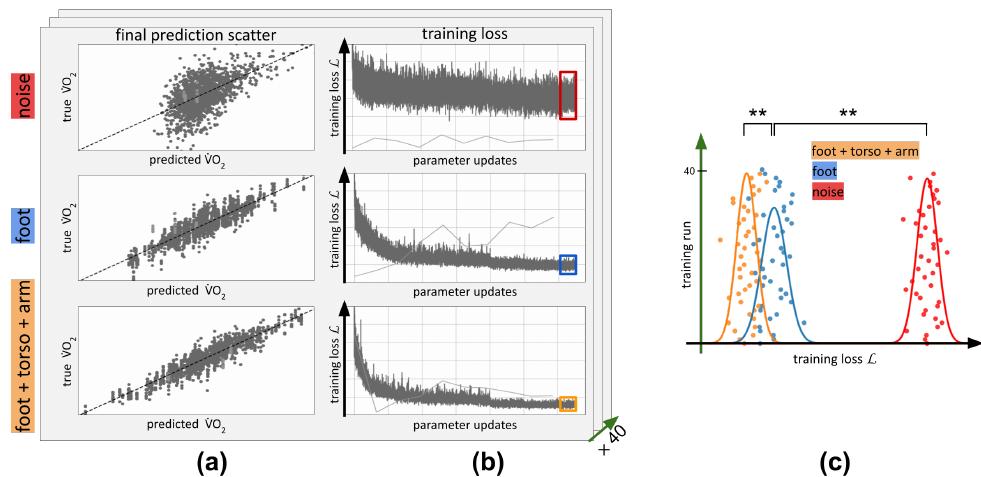
Figure 5. ( a ) Scatter plot of predicted ˙VO 2 (normalized by body weight and pace) versus correct ˙VO 2 for a completely trained network. Top: training on noise, middle: training on foot acceleration A f , bottom: training on acceleration from the foot, torso, and arm proportional to the coefficient of determination in this scatter plot and is optimized throughout training by updating the parameters of the model. ( b ) The progression of training loss L over time for our model in the three different conditions. The average loss L of the last 20 training steps (red/blue/orange boxes) is used to compare noise/foot/foot+torso+arm in ( c ). The single stray light gray shows the validation loss, which does not converge. ( c ) Averages of final training losses L over 40 repetitions. Orange: Foot + torso + arm, blue: foot, red: noise. Lines = fitted student-t distribution over the respective repetitions. **: statistically significant difference, p <